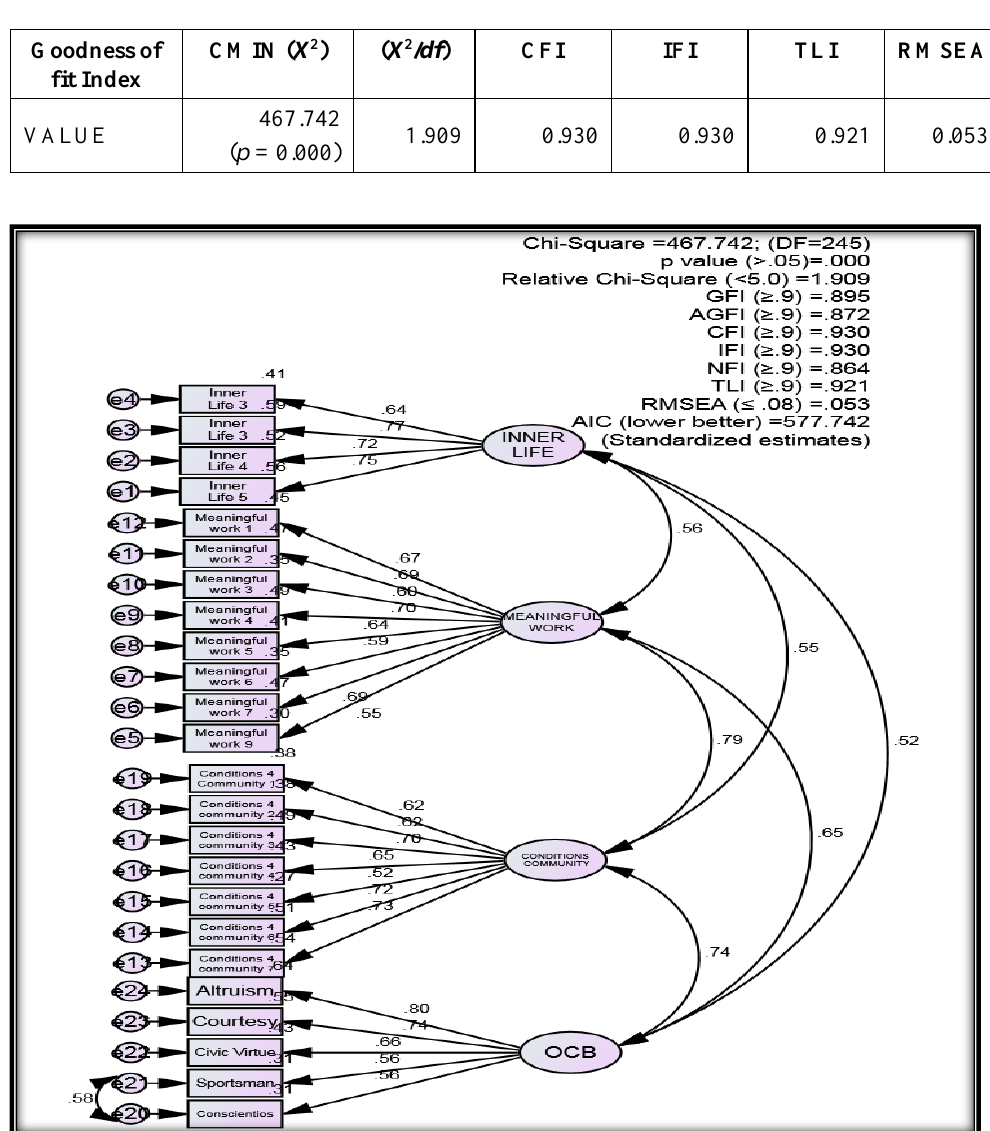
Fig. 2. Measurement model used in this study